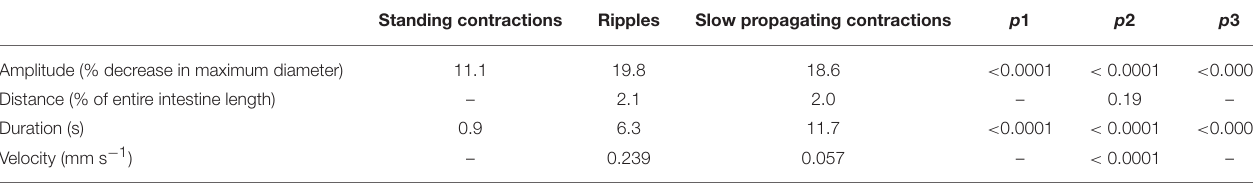
TABLE 2 | Median amplitude, duration, and velocity of the three contraction types.